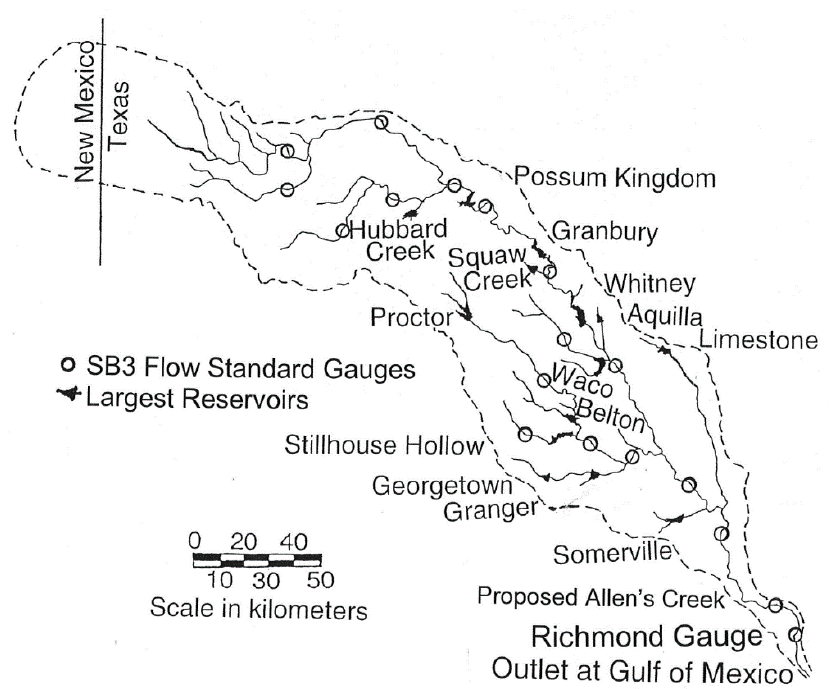
Figure 2. Sixteen largest reservoirs and nineteen gauge sites with SB3 EFS in the Brazos River Basin [27].